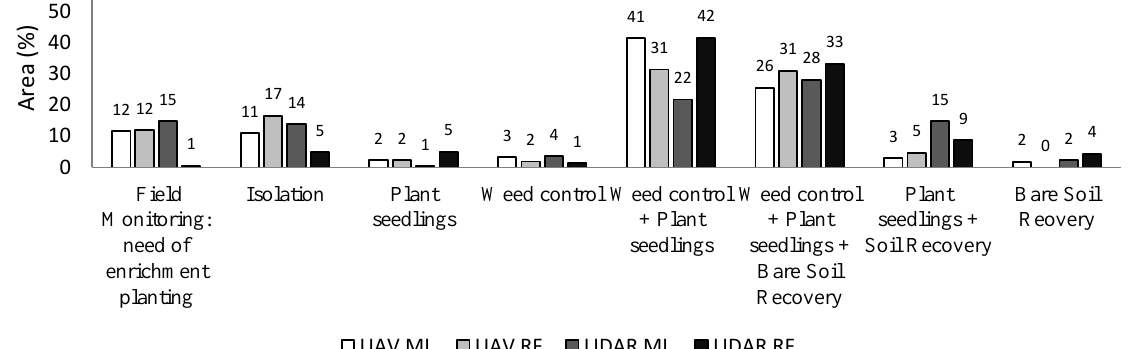
Figure 6. Area percentage occupied by each management recommendation according to different monitoring methods, images from LiDAR (Light Detection and Ranging) and UAV (Unmanned Aerial Vehicle), classified by ML (Maximum Likelihood) and RF (Random Forest) algorithms. Table 3. Example of a recommendation table generated by the model builder. The rows represent a certain restoration area inside the farm (T734).